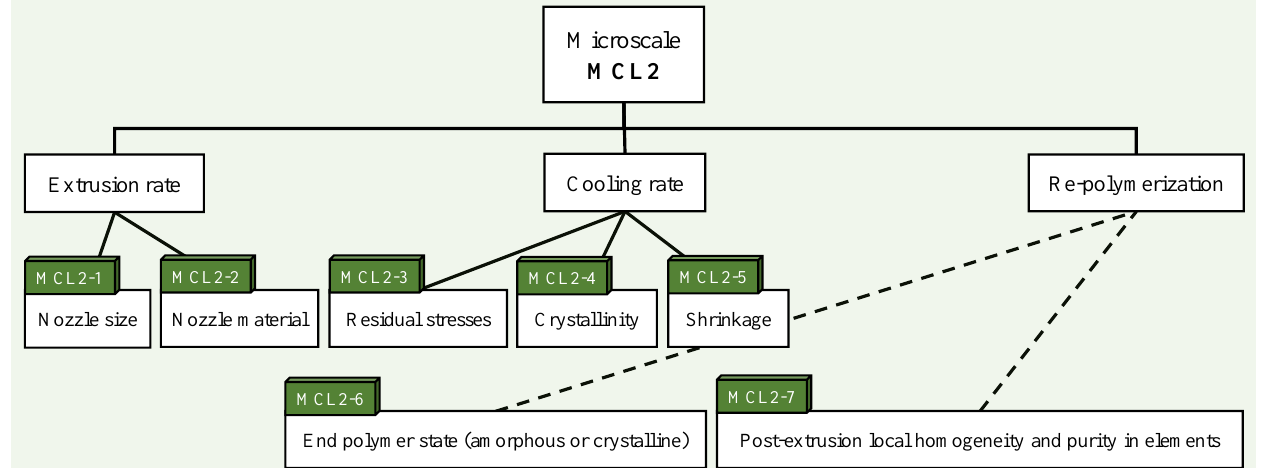
Figure 8. Essential manufacturing constraints at the microscale